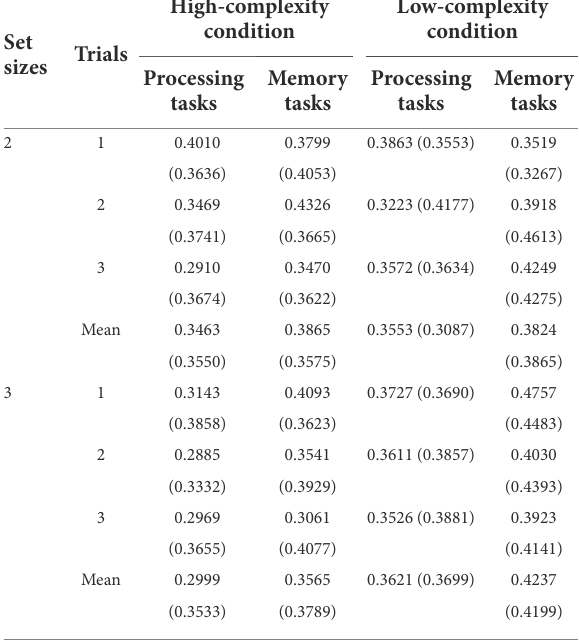
TABLE 4 Mean (SD) of pupil dilation during processing and memory tasks.